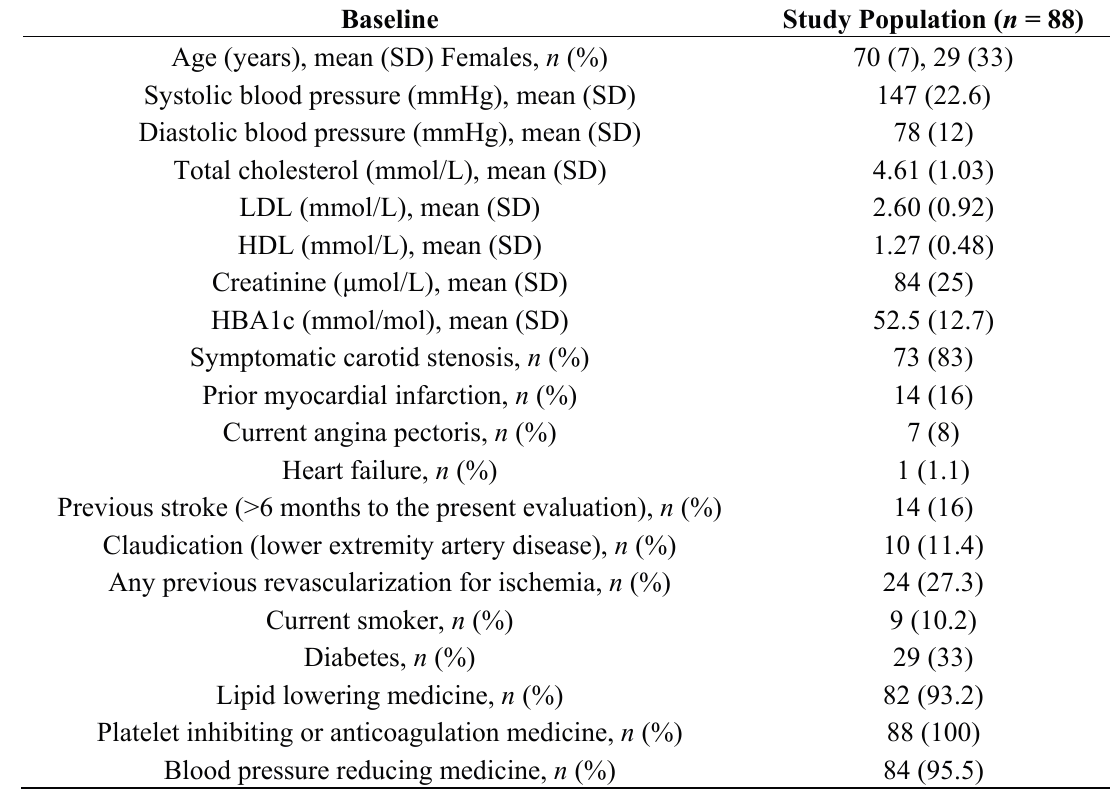
Table 1. Baseline characteristics of the study